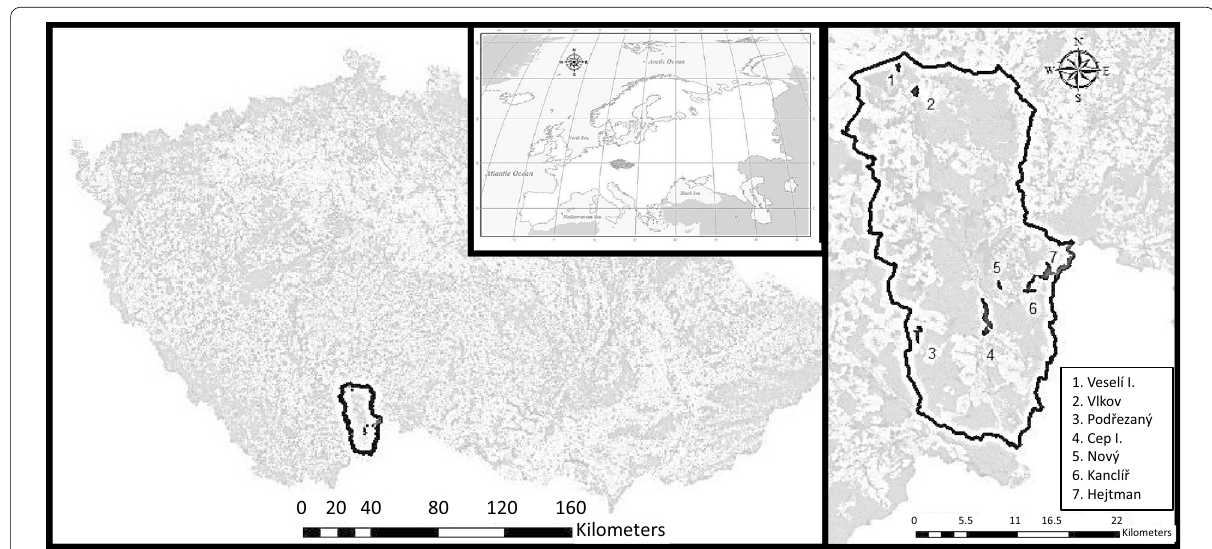
Fig. 1 Map representing the sampled locations from the Třeboňsko region in the Czech